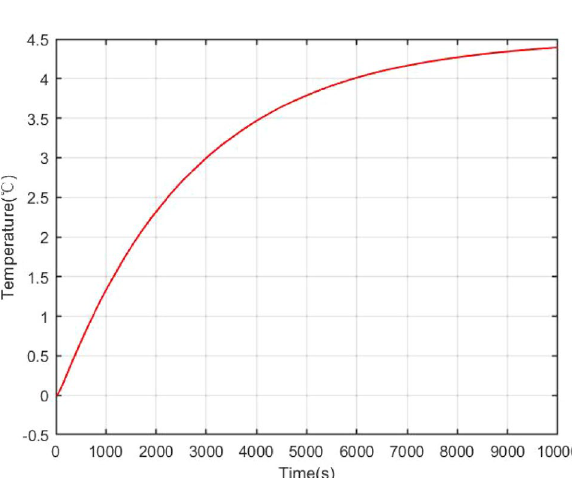
Figure 6. Open loop response of steam generator outlet temperature under reactive